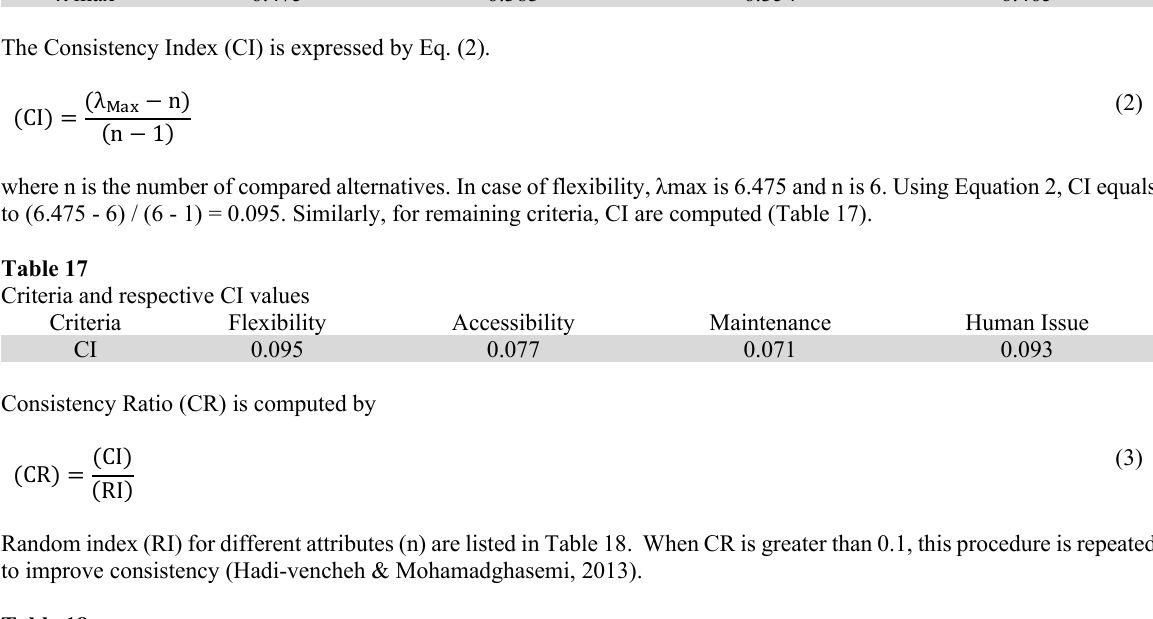
Criteria and respective eigenvalues ( λ max) Criteria Flexibility Accessibility